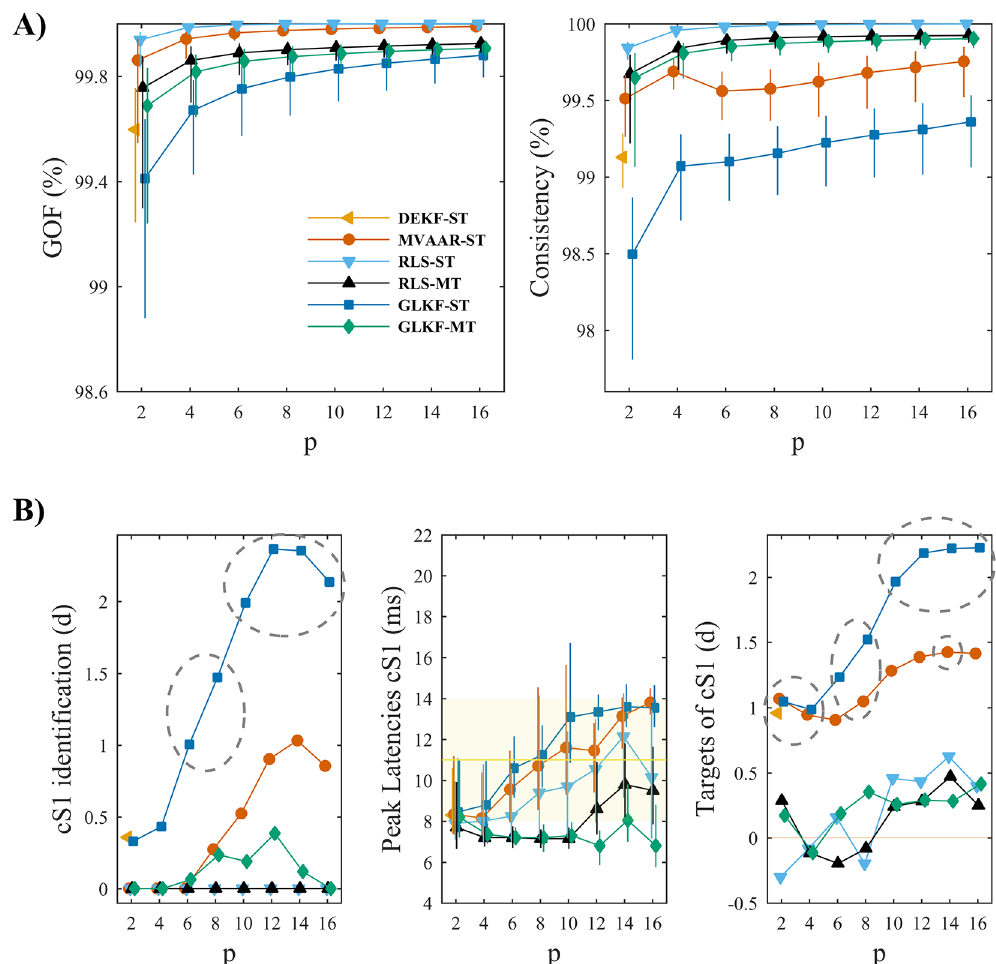
Fig 8. Effects of model order selection in benchmark EEG data. A) Shows the measures of model quality, goodness-of-fit (left) and percent consistency (right). Error bars denote bootstrapped 95% CI around the mean across animals. B) Shows the results of the performance assessment using the three performance criteria. Criterion I (left): gray dashed ellipses indicate conditions in which cS1 was significantly distinguished as main driver of the network. Criterion II (center): error bars denote bootstrapped 95% CI around mean peak latency across animals, while yellow band shows the range of physiologically plausible latencies after stimulus onset. Criterion III (right): dashed ellipses indicate conditions in which the driving from cS1 toward its two main targets was significantly larger than to medial electrodes equidistant from cS1. In each plot the results are shown varying model order p , for the four recursive algorithms and the two ways of exploiting multiple trials: single-trial modeling and multi-trial modeling, available only for RLS and